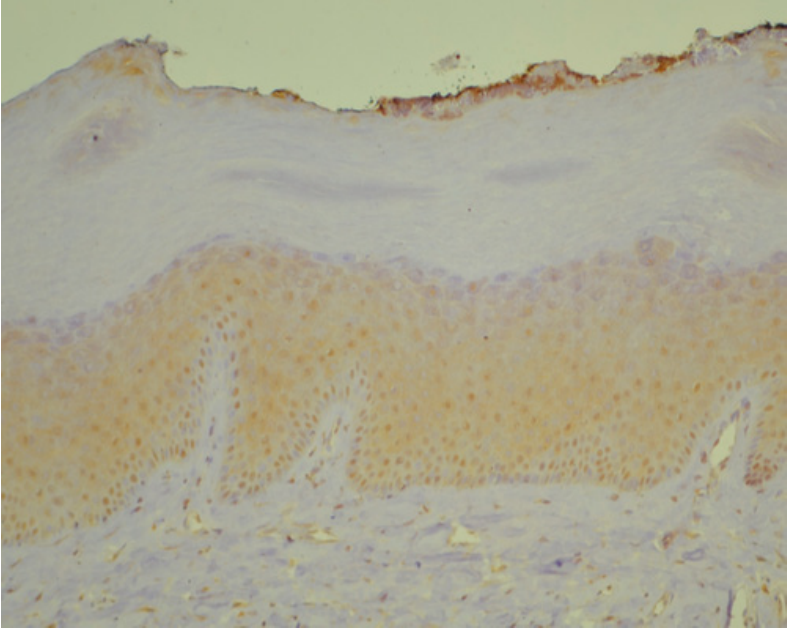
Figure 2. IL-1 α —moderate brown staining in epithelum (all layers) of oral leukoplakia without dysplasia (OL) (20x).